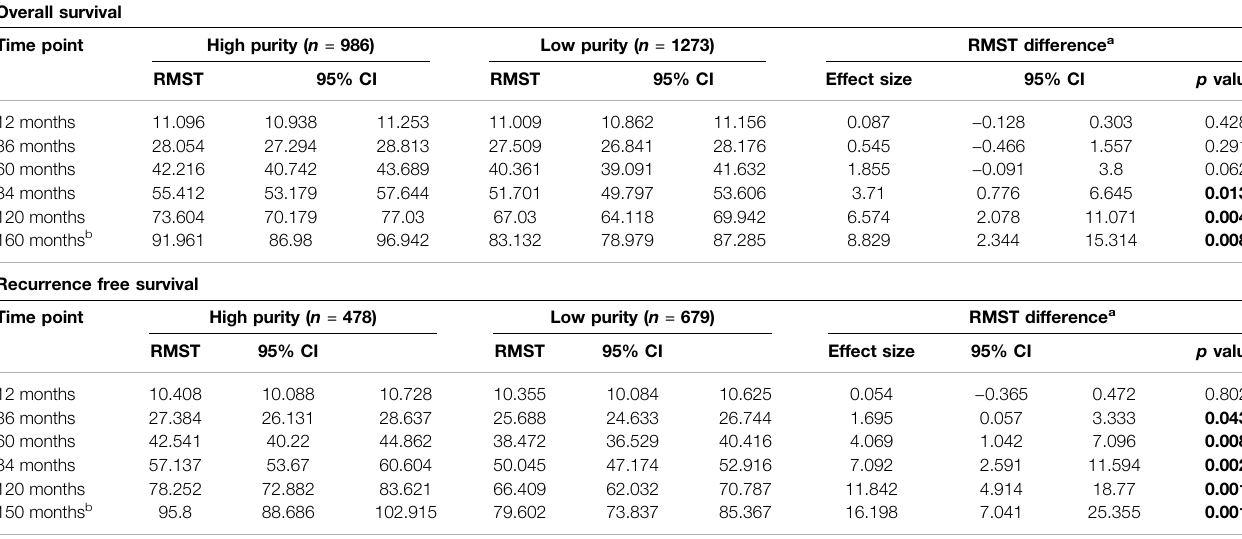
TABLE 2 | Restricted mean survival time (RMST) differences in different time points. Overall survival